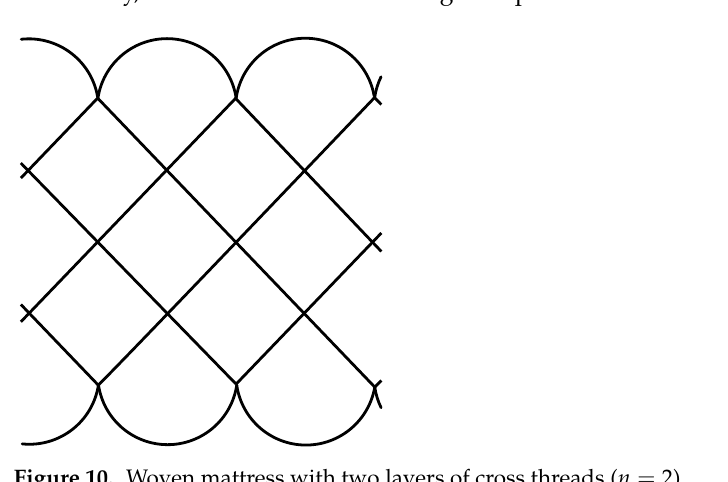
Figure 10. Woven mattress with two layers of cross threads ( n = 2).